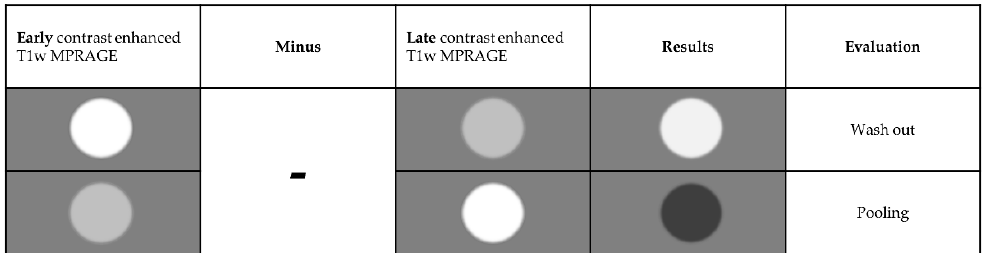
Figure 3. Principle of wash out and pooling. Tissue with higher contrast enhancement in early phase than in the late phase was labeled as wash out and has been evaluated as “suspect” (i.e., tumor recurrence). On the other hand, tissue with a continuous increase in contrast agent enhancement over time was labeled as pooling and evaluated as “not suspect” (TRCE; such as “pseudo tumors” or “pseudo progression”). Subtraction of late from early phase resulted in bright signals for suspect lesions and dark correlates for no suspect (see following figures).